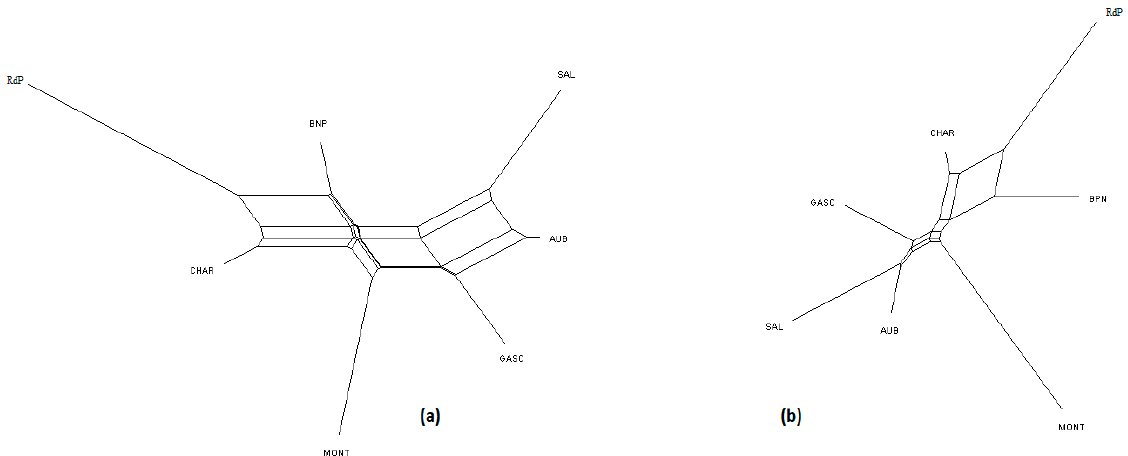
Figure 2. NeighborNet graph considering French cattle breeds, from a matrix of Reynolds’ distances. ( a ) Plot obtained from the microsatellite dataset; ( b ) plot obtained from the SNP dataset. For breed names see codes in Table S1.